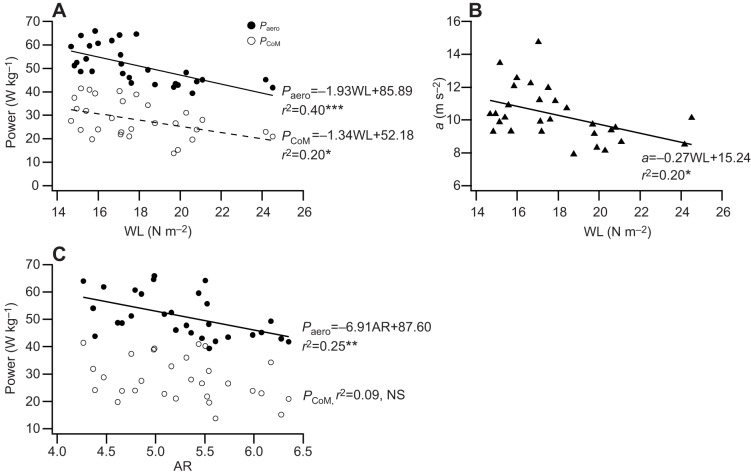
The effects of wing morphology on take-off flight performance in blue tits. Relationship between WL and (A) Paero and PCoM, and (B) acceleration (a) of the CoM. Relationship between AR and (C) Paero and PCoM. The solid lines are least-squares regressions (*P<0.05, **P<0.01 and ***P<0.001, N=29).